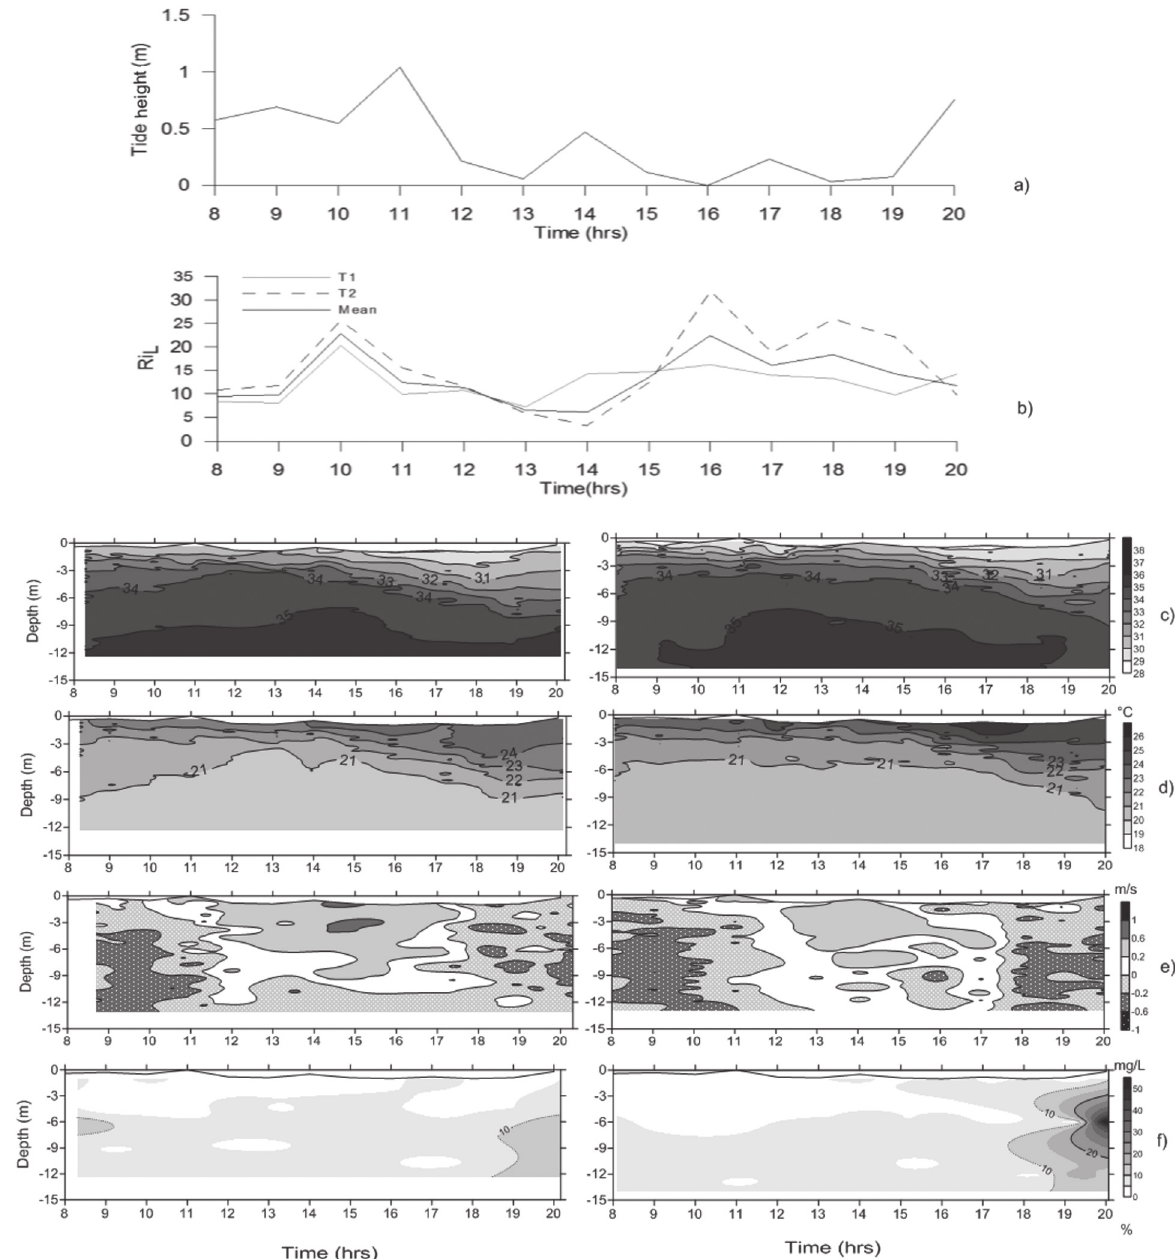
Figure 3 - Temporal profiles of QC (neap cycle during the rainy season - 11/29/2010); a) tide elevation (m); b) Layer Richardson number; c) salinity (PSU) d) temperature (°C); e) longitudinal velocity (m/s); f) SPM (mg/L); .Left column is station T1 and right column station